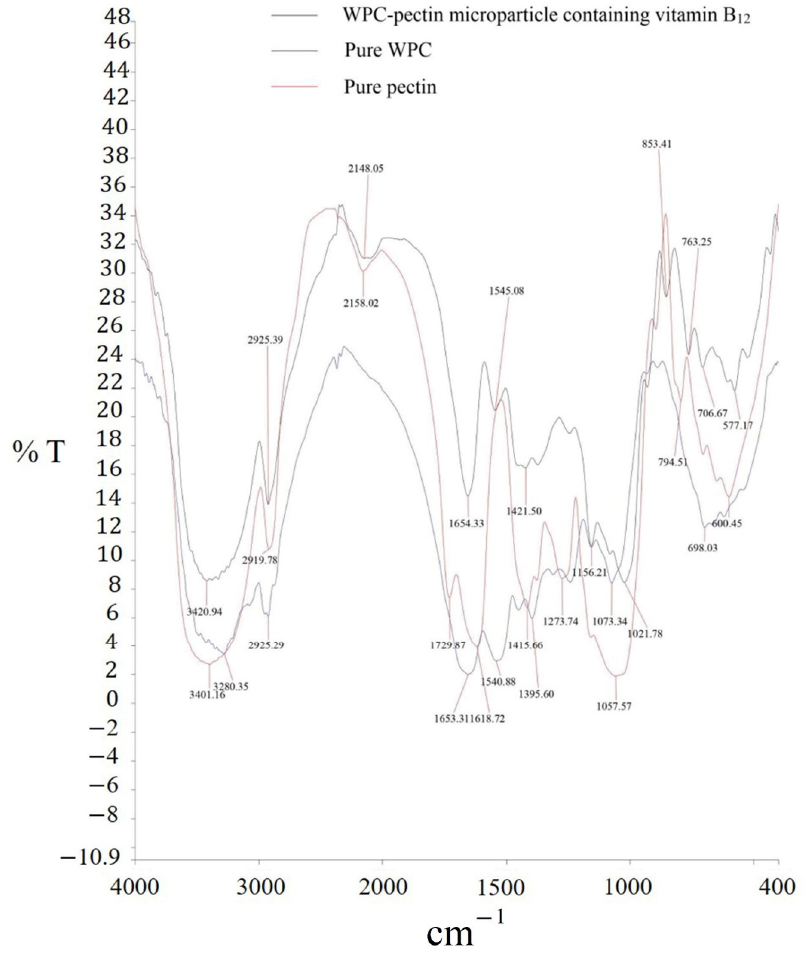
Figure 3. FTIR spectra of pure pectin, WPC and WPC–pectin complex carriers containing vitamin B 12 .